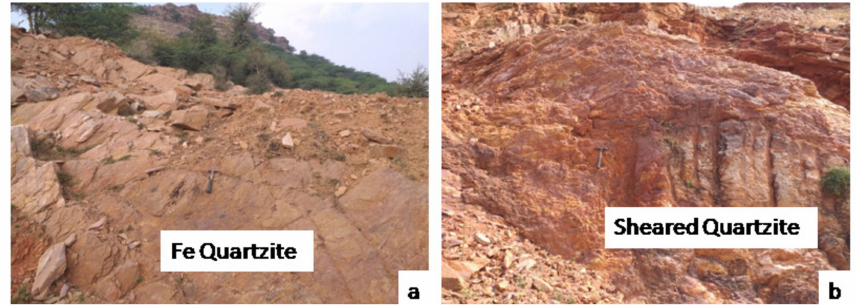
Figure 15. ( a ) The exposures of foliated and altered Fe rich quartzite near Lanpriya village. ( b ) The surface exposures of sheared and sericitized Fe-rich quartzite near Lanpriya village. Surface exposure of calcite-rich veins and sericitized zones were also identified within BMQ at the Mangalpura area (Figure 16a). Calcite-rich zones are pinkish-red, and sericitised zones are green-colored patches within BMQ, which is in turn enhanced with blue color in the RBD image of alteration minerals (Figure 15a). Evidence of ductile deformation was also prominent in this area (Figure